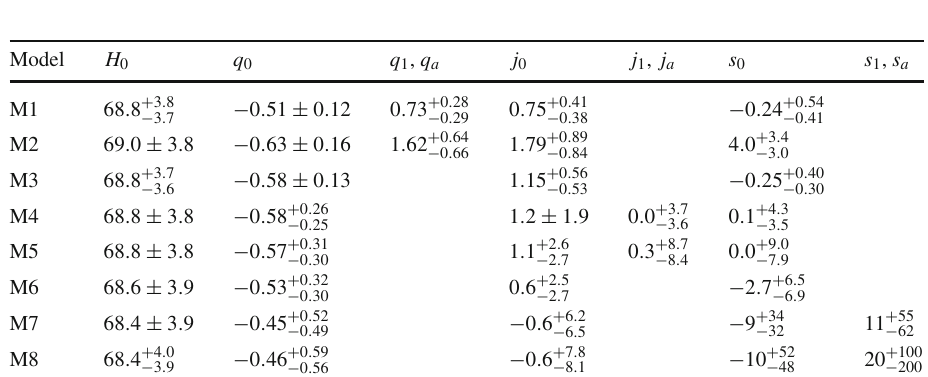
kinematic parametrizations, with mean values of the parameters and 95% c.l.